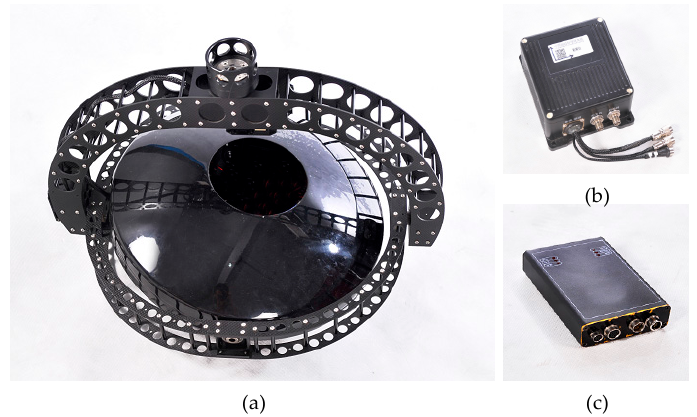
Figure 5. Images of the three-axis stabilization platform for unmanned airship aerial photogrammetry platform. ( a ) Mechanical rotating platform; ( b ) GNSS/INS system; ( c ) PID control microcomputer.